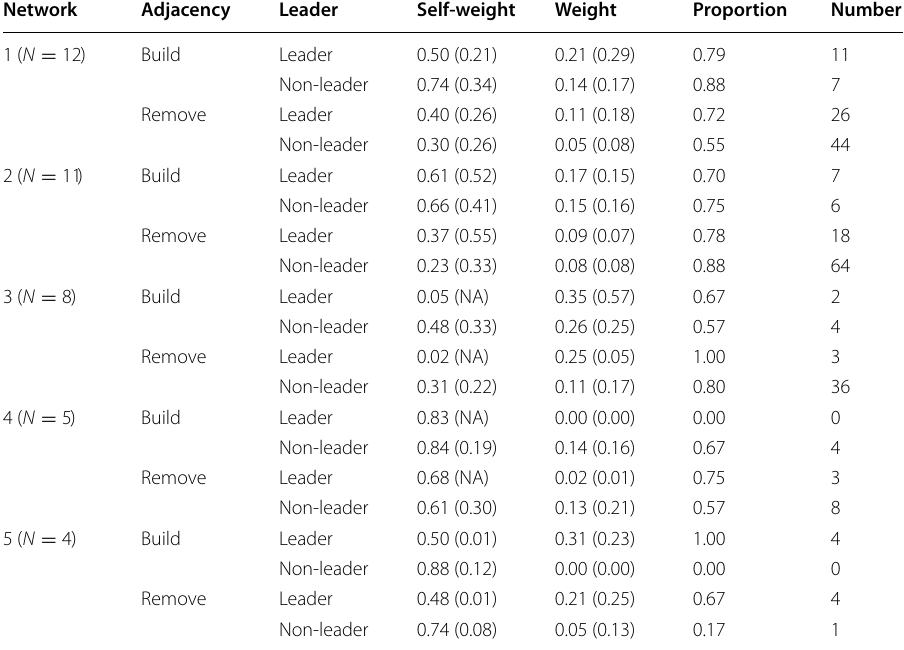
Table 19 Mean self-weight, mean weight, proportion, and number by network, adjacency matrix and leadership for willingness